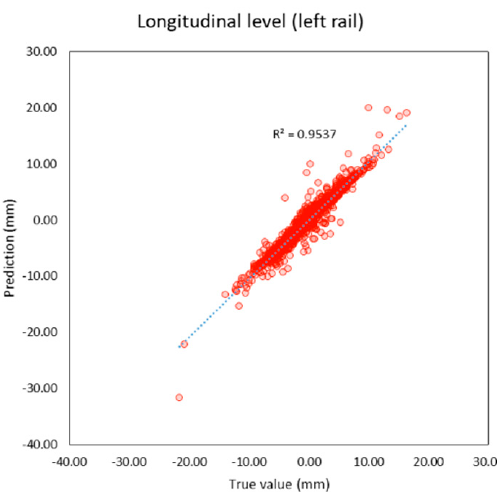
Figure 6. Correlation between true and predicted values of longitudinal level (right rail).